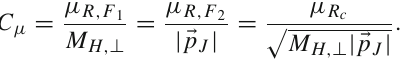
iliary, independent Mathematica interface allowed us